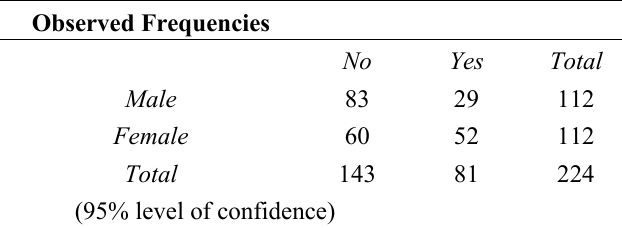
Table 7. Cross tabulation analysis between gender and anxiety.